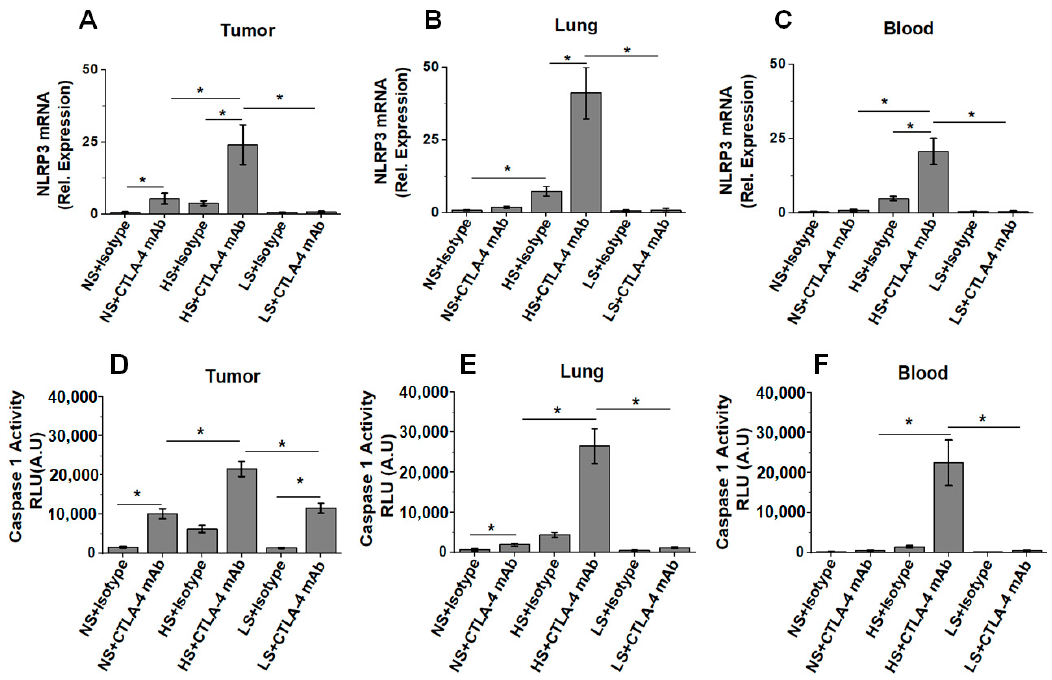
Figure 5. Inflammasome activation in high-salt-diet-fed breast-tumor-bearing mice following anti- CTLA4 mAb therapy. ( A – C ) The mRNA expression of NLRP3 in CD4+T cells isolated from tumor ( A ), lung ( B ) and blood ( C ) in NS, HS and LS diet cohorts following treatment with anti-CTLA4 mAb or isotype control. ( D – F ) Proteolytic enzyme caspase-1 activity in CD4+T cells isolated from tumor ( D ), lung ( E ) and blood ( F ) in NS, HS and LS diet cohorts following treatment with anti- CTLA4 mAb or isotype control. Data analyzed by one-way ANOVA for multiple comparisons; data presented as mean ± SEM, n = 8 (biological replicates) per cohort, (*) p -value < 0.05.